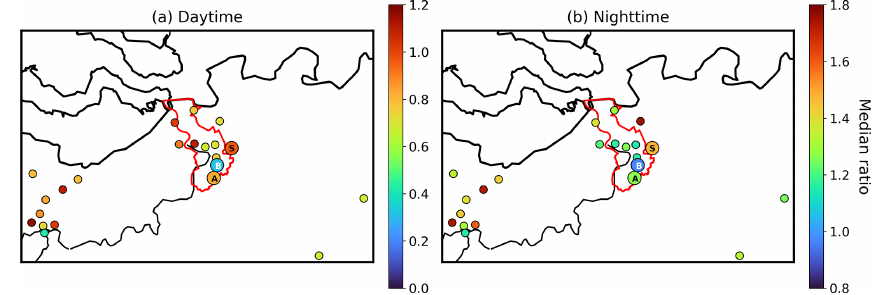
Figure 13. Median (a) daytime and (b) nighttime ratio (model/observation) of NO ∗ domain. Points “A”, “B”, and “S” denote the stations Antwerpen, Borgerhout, and